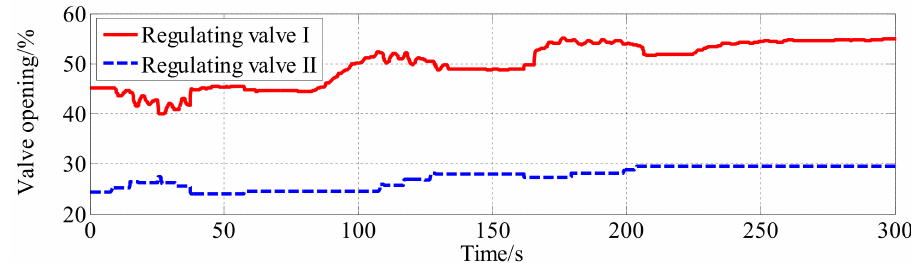
Figure 15. Opening change process of two regulating valves.